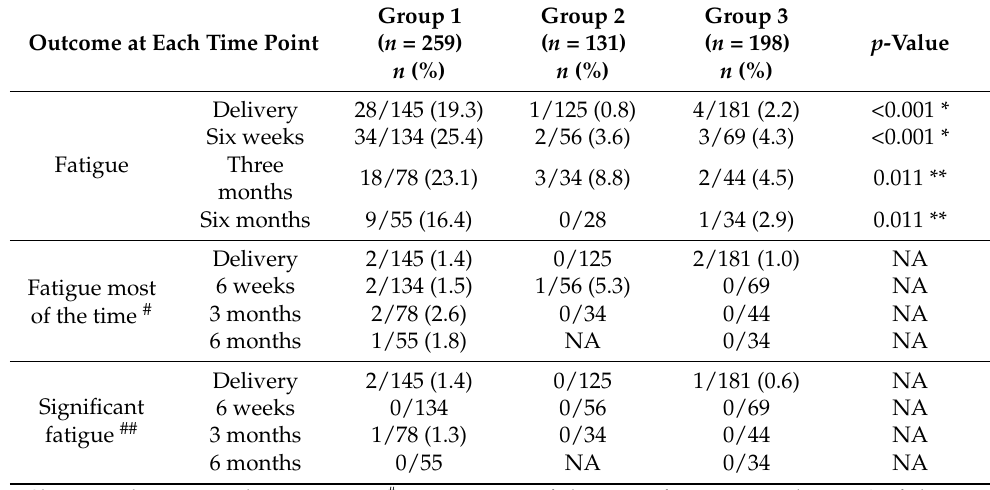
Table 5. Comparison of fatigue-related outcomes after delivery between the groups ( n = 588). Group Outcome at Each Time Point